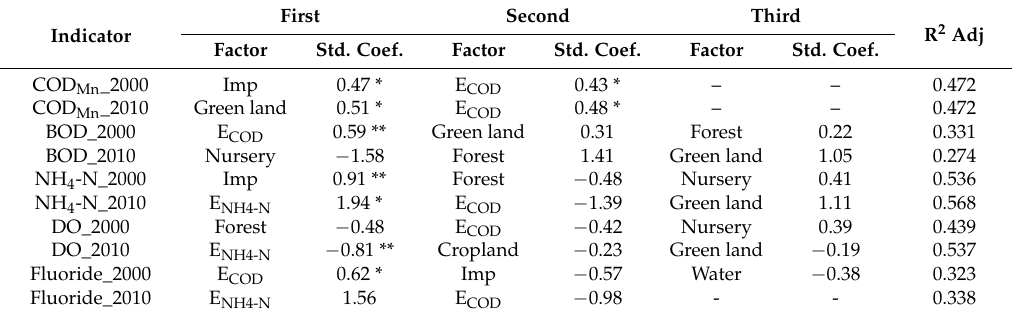
Table 3. Multiple regression analysis between land use types in 2000 m buffer, point source pollution emissions and water quality